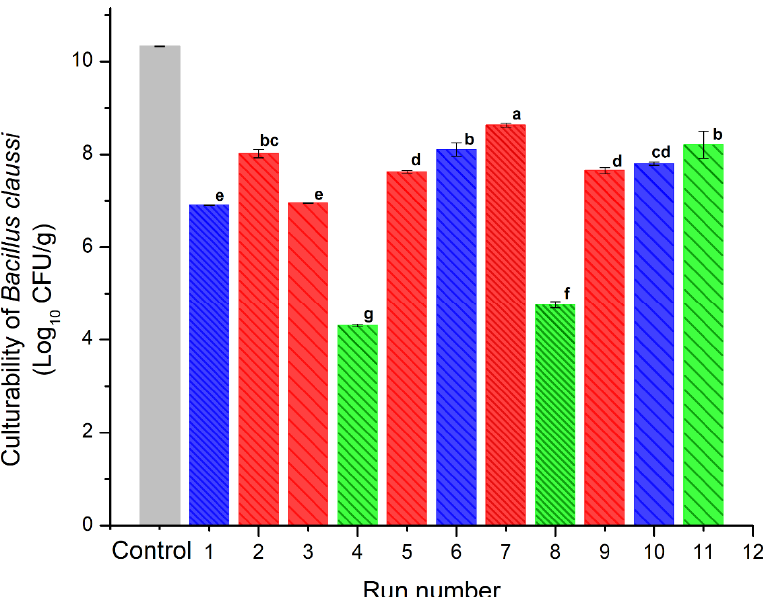
Figure 5. Culturability of B. clausii of the spray-dried powders containing the active ingredients (INMX_1–11). Bar color indicates the polysaccharide group (blue for MX, green for IN, and red for blends). Pattern thickness indicates the drying temperature (dense for low temperature, medium for intermediate temperature, and sparse for high temperature). Lowercase letters (a–g) indicate the Tukey’s test results at significance level of 0.05.